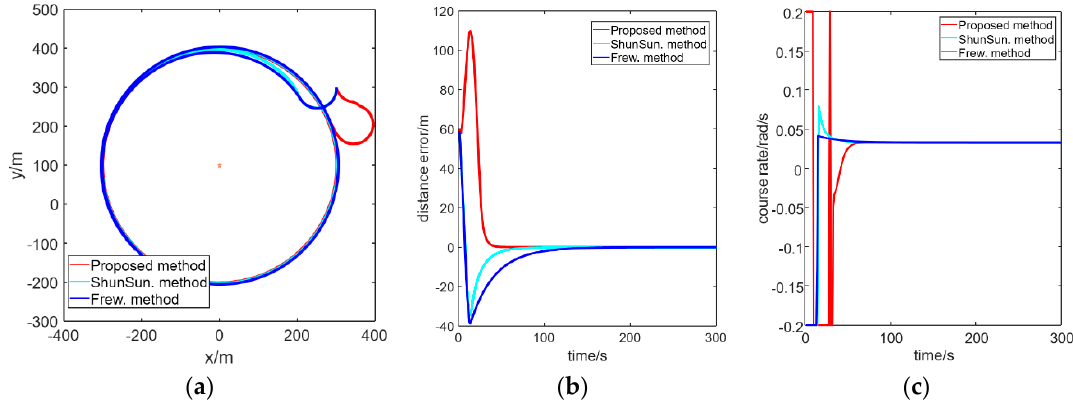
Figure 11. Experiments results with respect to an initial UAV position near the standoff circle. ( a ) Trajectories of UAVs; ( b ) Distance error versus time; ( c ) Course rate versus time.